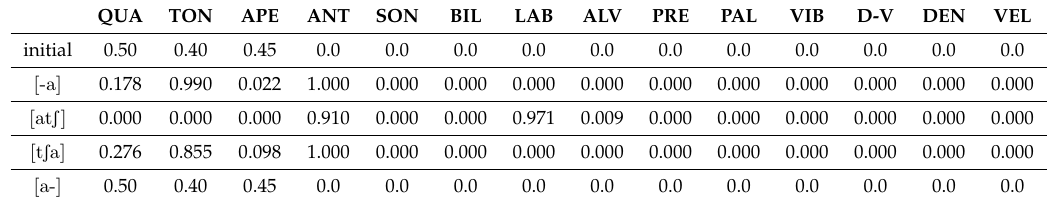
Table 6. Estimated articulatory parameters per transition.